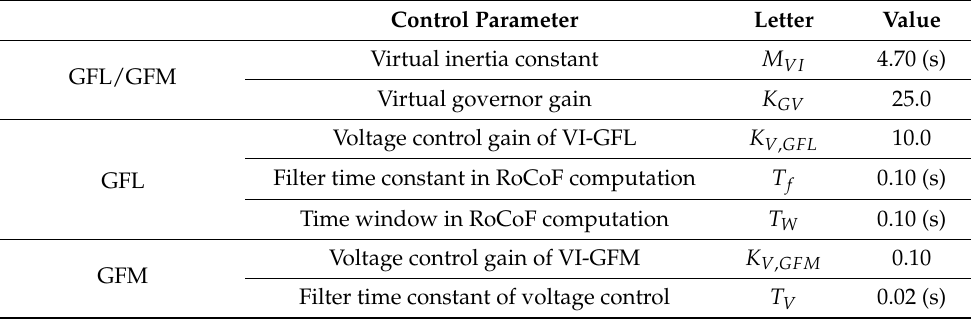
Table 3. Control parameters of the